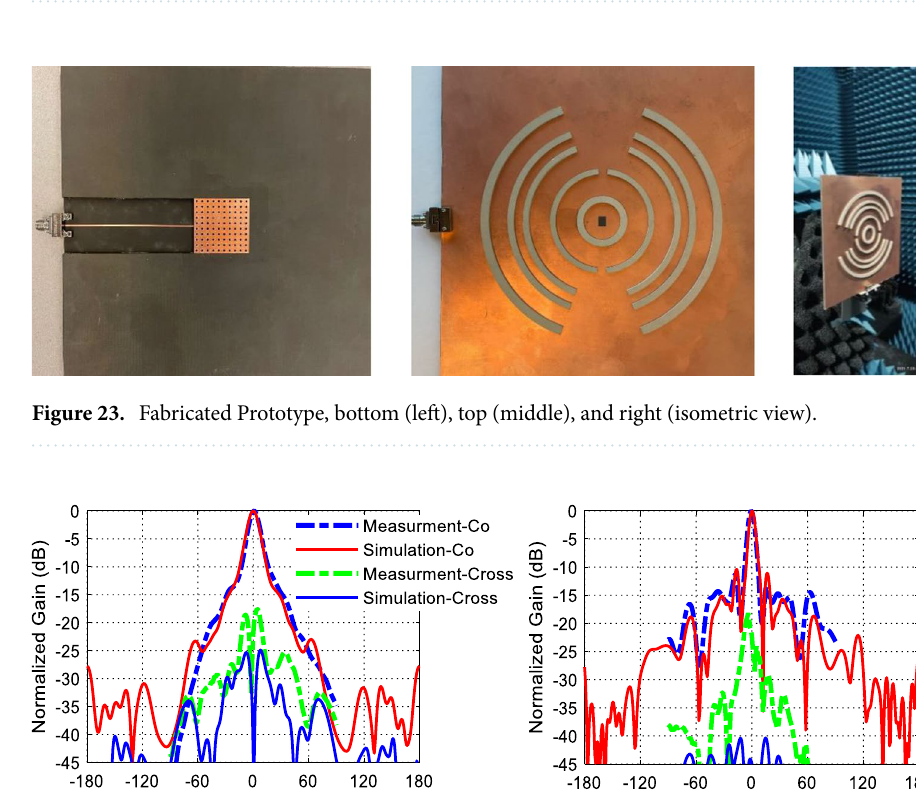
Table 3. Dimensions (millimeters).